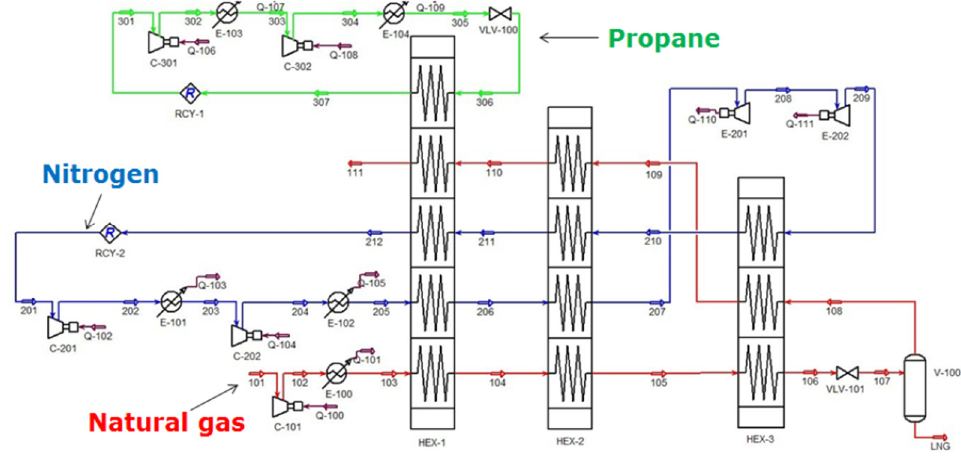
Figure 21. The nitrogen expansion liquefaction process with propane pre-cooling (NEC-Propane) [68]. Reproduced with permission from Elsevier (license number 5413401151821).